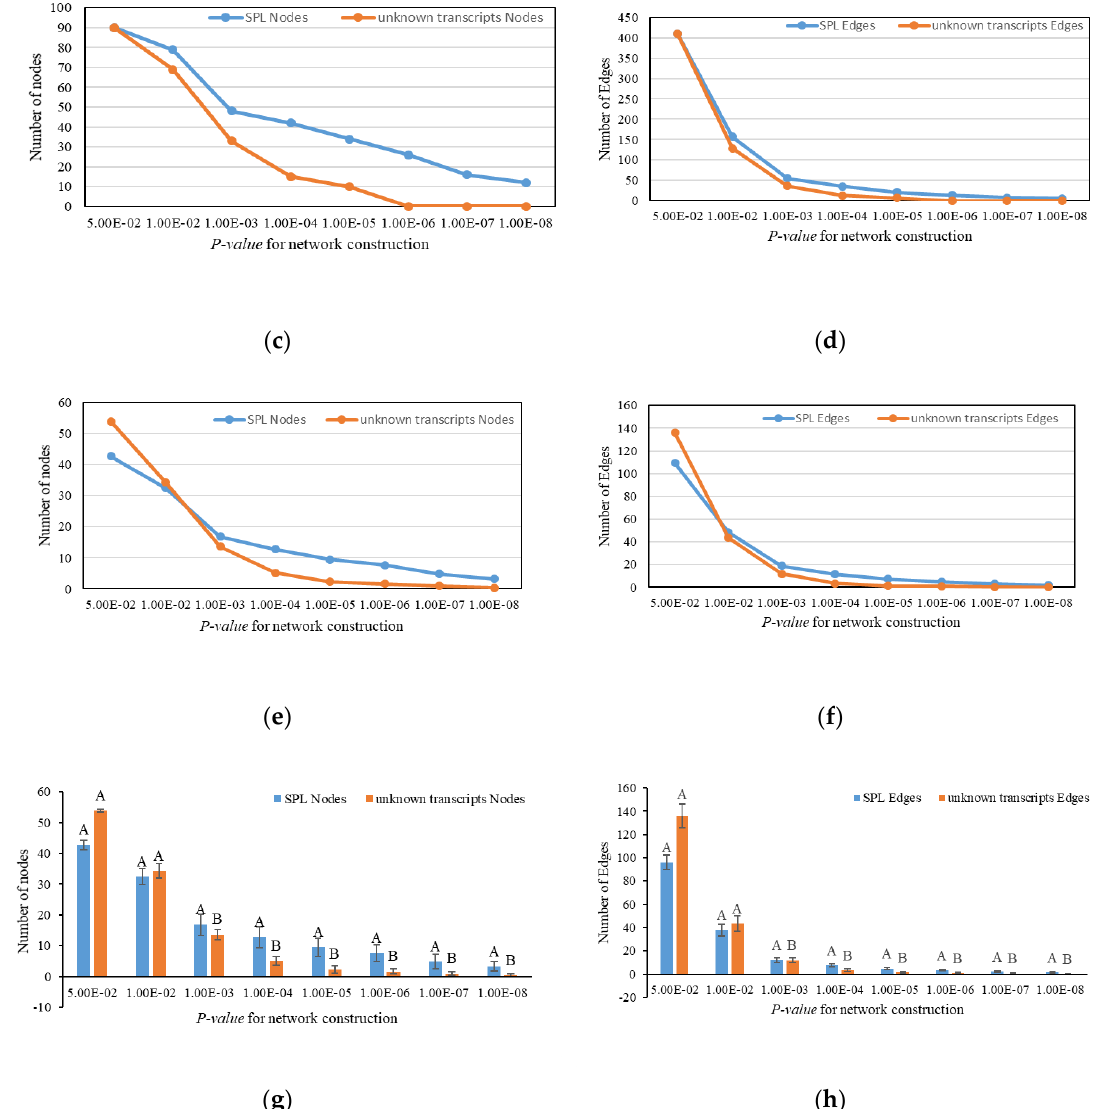
Figure 7. The network constructed at p ≤ 0.05, and its analysis of the PgSPL transcripts expressed in the 42 farmers' cultivars of 4 years old ginseng. ( a ) The network of all transcripts. ( b ) The networks of clusters. ( c ) Trend that numbers of nodes of all PgSPL transcripts under different p -values with unknown genes as controls. ( d ) Trend that numbers of edges of all PgSPL transcripts under different p -values with unknown genes as controls. ( e ) Trend that numbers of nodes of randomly drawn 60 PgSPL transcripts under different p -values with unknown genes as controls. ( f ) Trend that numbers of edges of randomly drawn 60 PgSPL transcripts under different p -values with unknown genes as controls. ( g ) Statistics of the numbers of nodes of randomly drawn 60 PgSPL transcripts under different p -values with unknown genes as controls. ( h ) Statistics of the numbers of nodes of randomly drawn 60 PgSPL transcripts under different p -values with unknown genes as controls. In (g) and (h), the error bars are standard deviation for 20 replications.